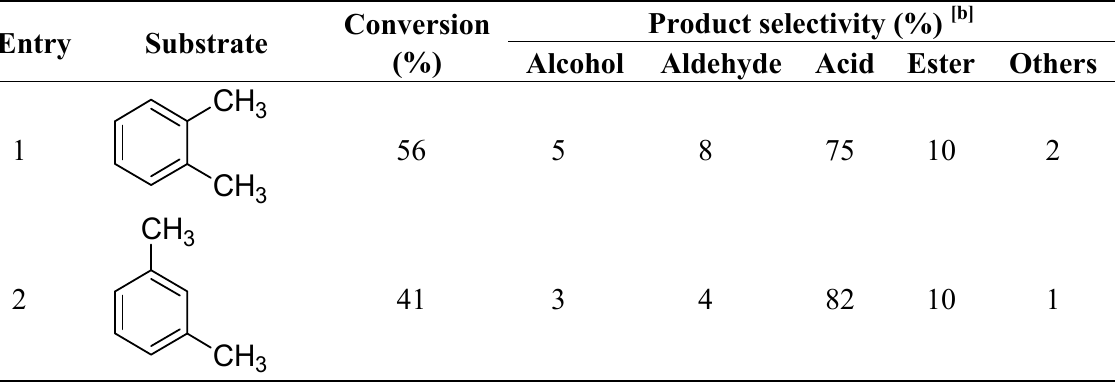
Table 3. Oxidation of different methyl aromatics [a]